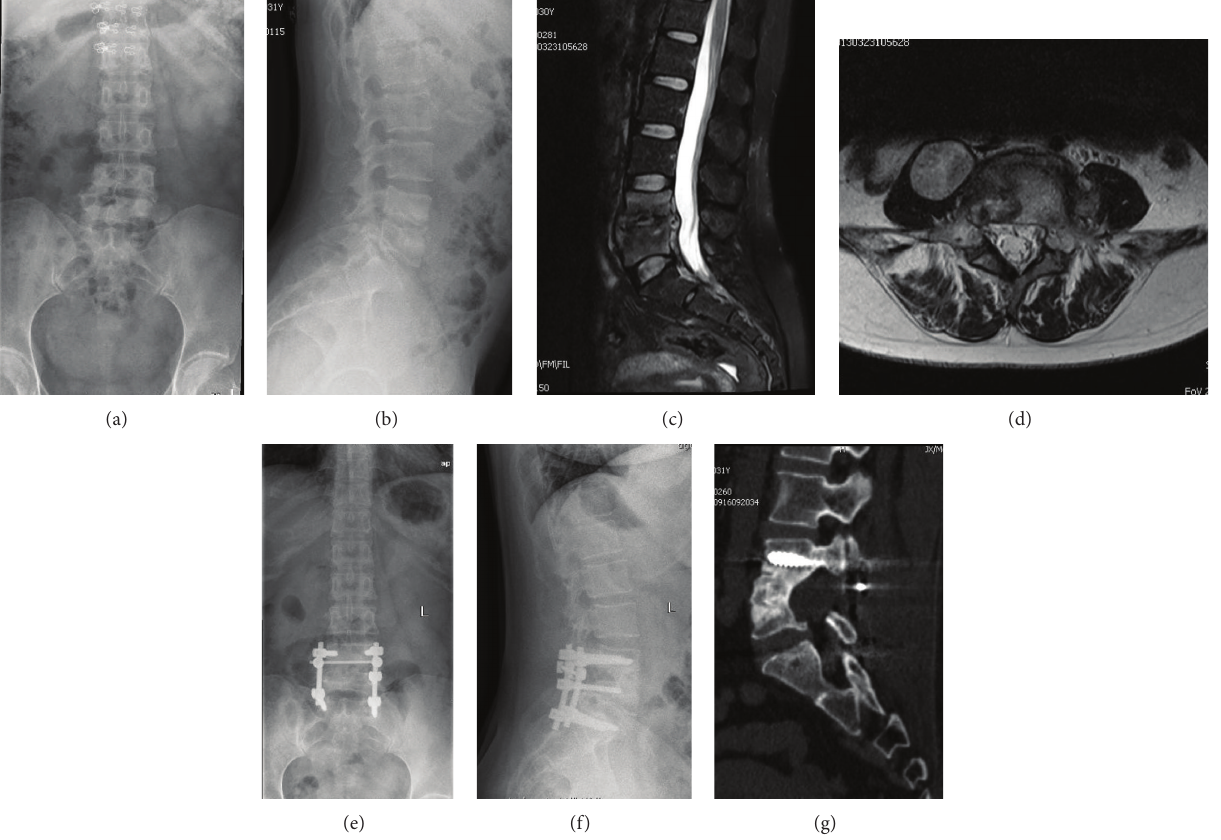
Figure 1: A 30-year-old female patient presented with spinal tubercular spondylodiscitis at L4-5 with a paravertebral abscess (a–d). After one-stage posterior debridement, interbody fusion with autogenous bone grafting, and fixation with pedicle screw, this defect of the spine was reconstructed in sagittal profile (e, f). 12 months postoperatively, a successful bony fusion was observed in reconstruction CT film